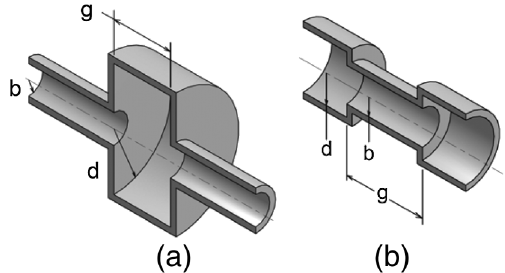
FIG. 1. (a) Pillbox cavity. (b) Step